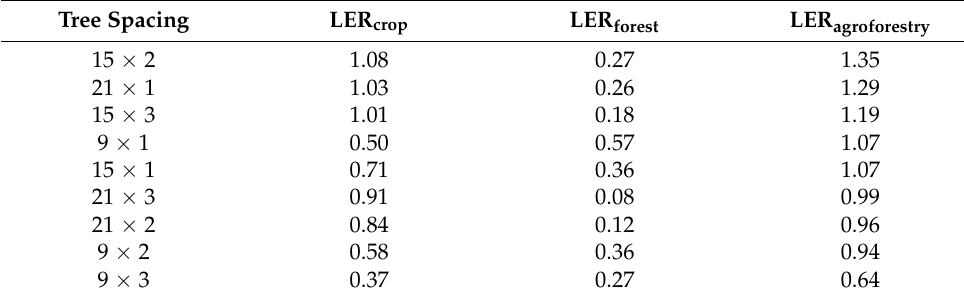
Table 5. Land equivalent ratios (LER) for each tree spacing. Tree